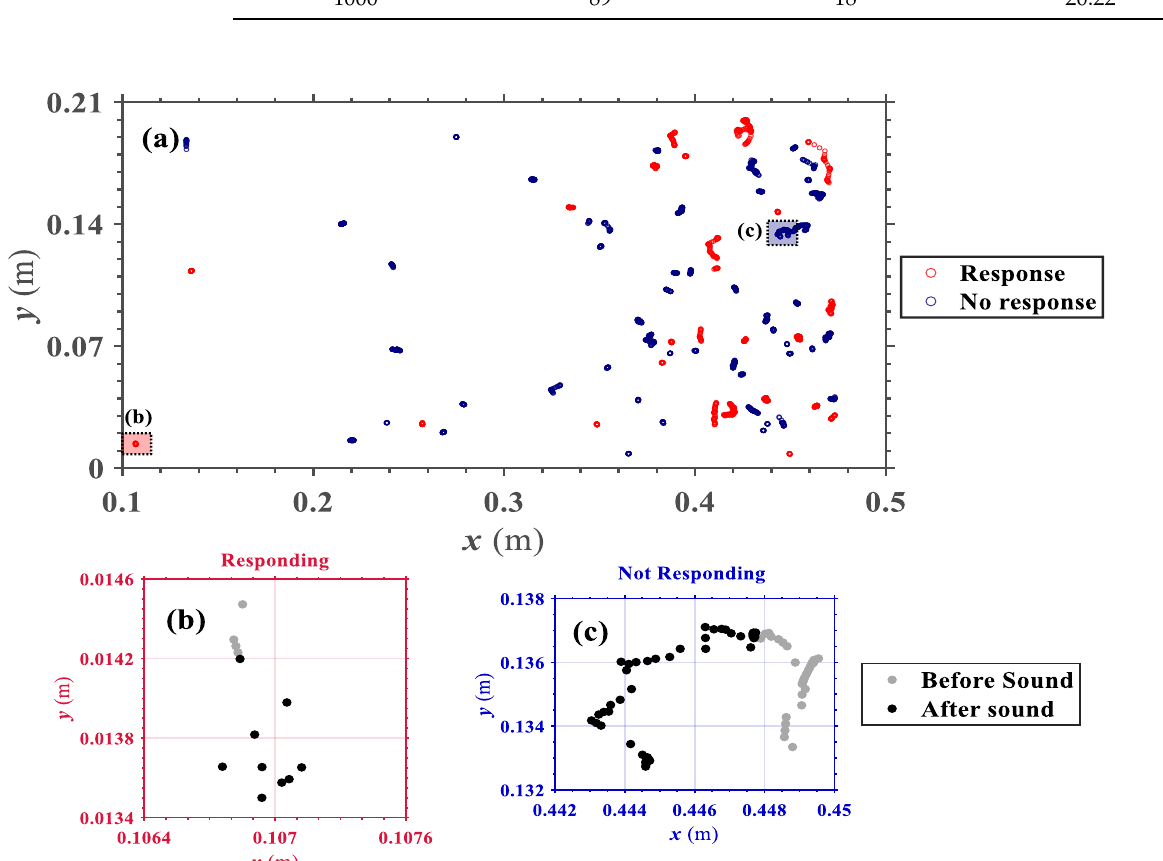
Figure 5. ( a ) Spatial distribution of larvae showing a response to sound and their trajectories over 90 frames. Sub-domains inside the Figure 5a that are marked with transparent red and blue colors are zoomed-in at beneath 5( b ) and 5( c ) respectively. ( b ) Example of larvae with subtle movements, but defined as having response to sound stimuli. ( c ) Example of larvae constantly moving throughout the entire time frame and thus defined as having no response to sound stimuli. The figure was obtained for larvae exposed to sound of 700 Hz, which led to the highest response ratio among larvae.